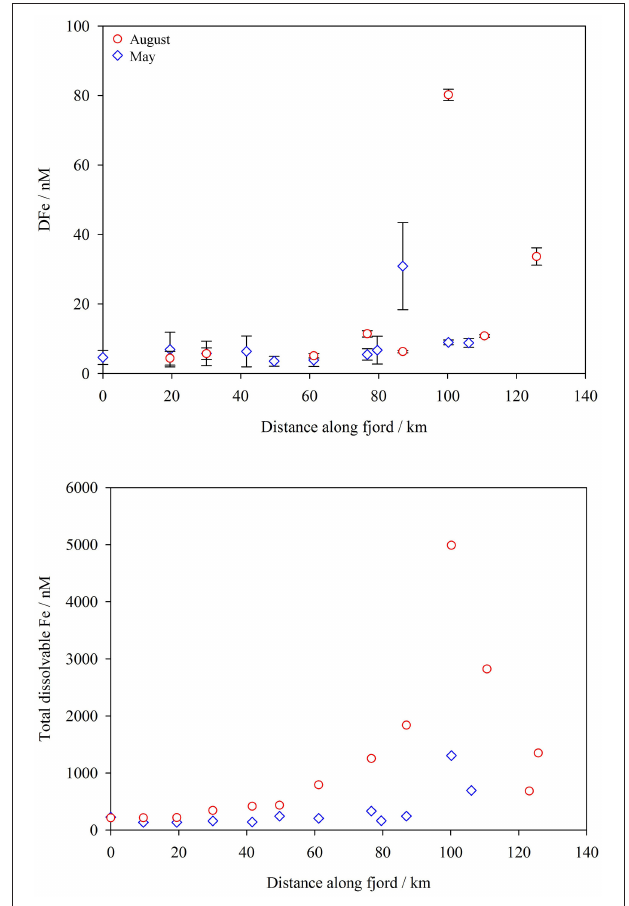
FIGURE 6 | Top: dissolved Fe (DFe, < 0.2 µ m) concentrations in the surface waters of Godthåbsfjord May (blue diamonds) and August (red circles) 2014. Plotted as distance from GF2. Bottom: total (dissolvable in unfiltered samples at pH < 2.0) Fe concentrations in the surface waters of Godthåbsfjord May and August